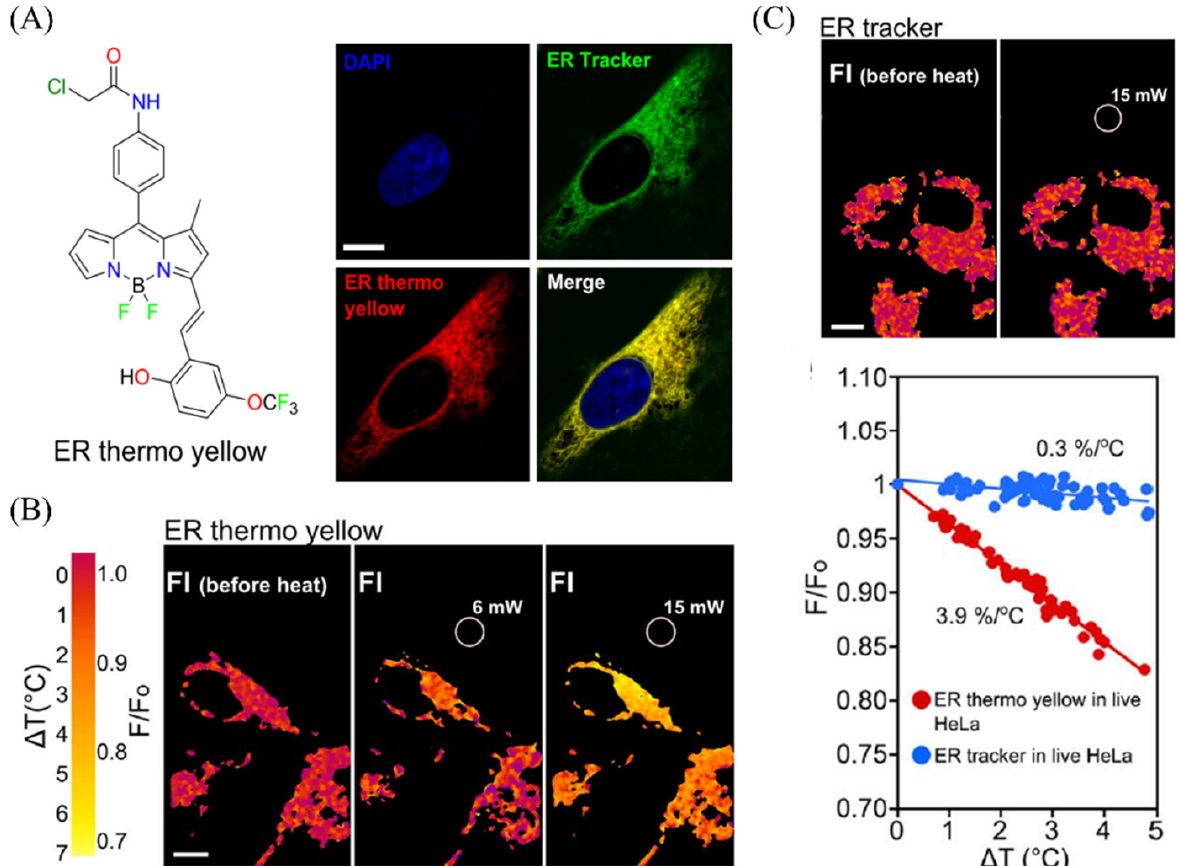
Figure 25. ( A ) the molecular structure of ER probes (ER thermos yellow) for visualizing ER in HeLa cells. ( B ) The temperature pictures of ER thermos under diverse laser powers (6 mW,15 mW). ( C ) The temperature pictures of ER tracker under 15 mW laser powers, and the corresponding data. Reproduced from [120] with permission of the Springer Nature, copyright 2014.